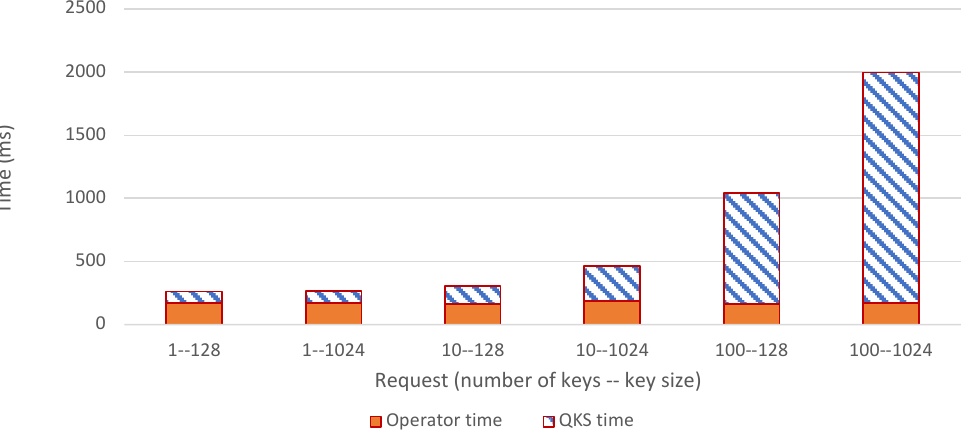
Figure 8. Execution time to handle a KeyRequest resource